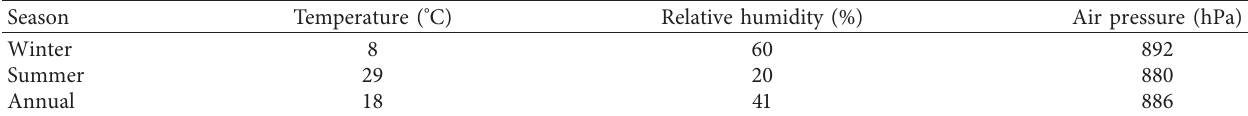
Table 3: The meteorology indices during summer, winter, and year.